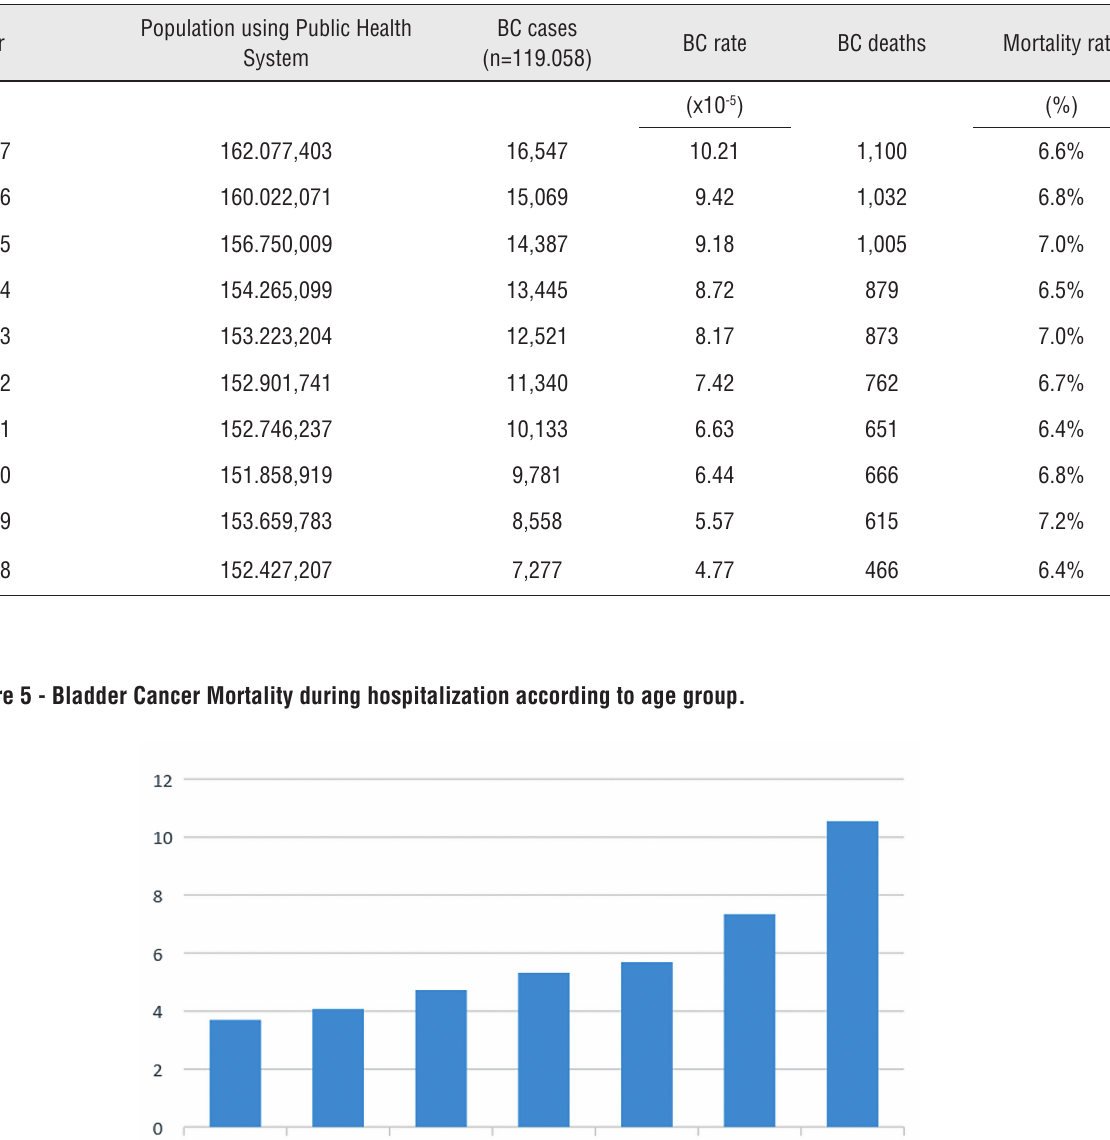
Table 1 - BC Admissions, Deaths and Mortality Rates from 2008-2017.